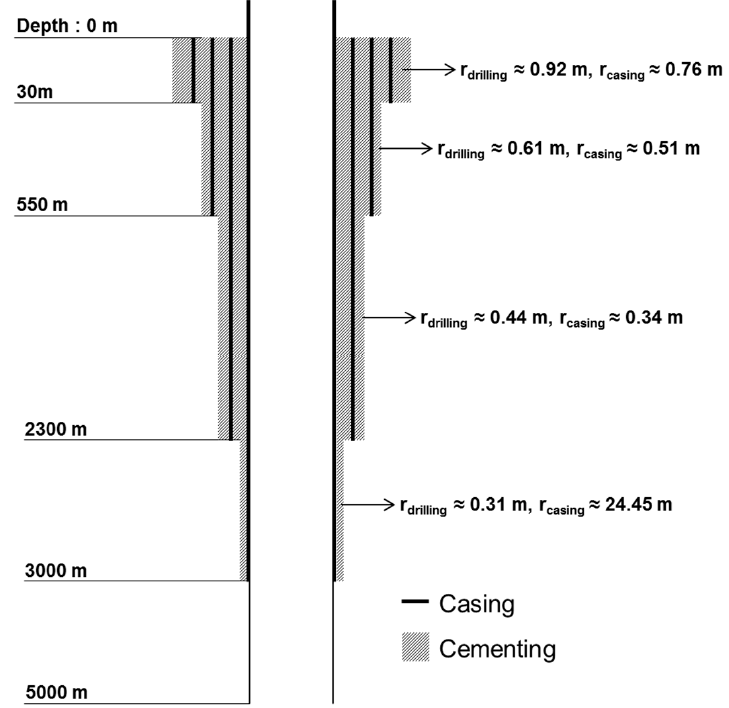
Figure 4. Schematics of geothermal well design adopted in numerical analyses: r drilling and r casing represent radius of drilled borehole and casing.